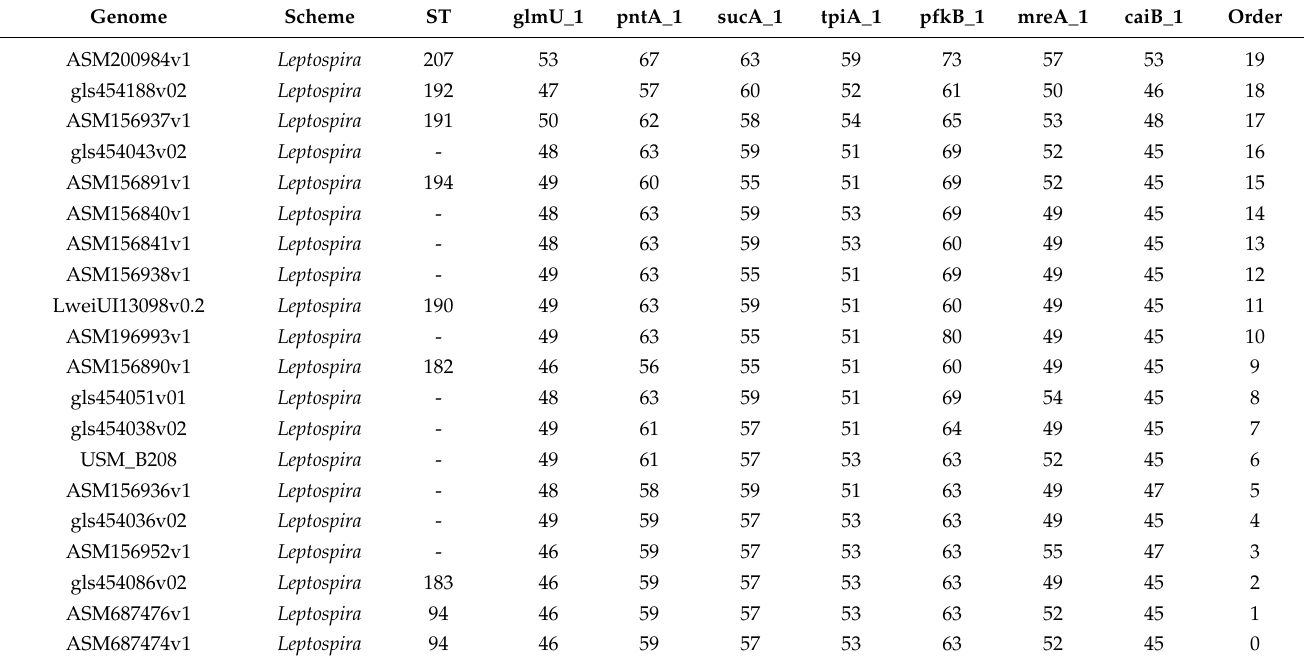
Table 5. Raw output result from the MLST software for L. weilii .